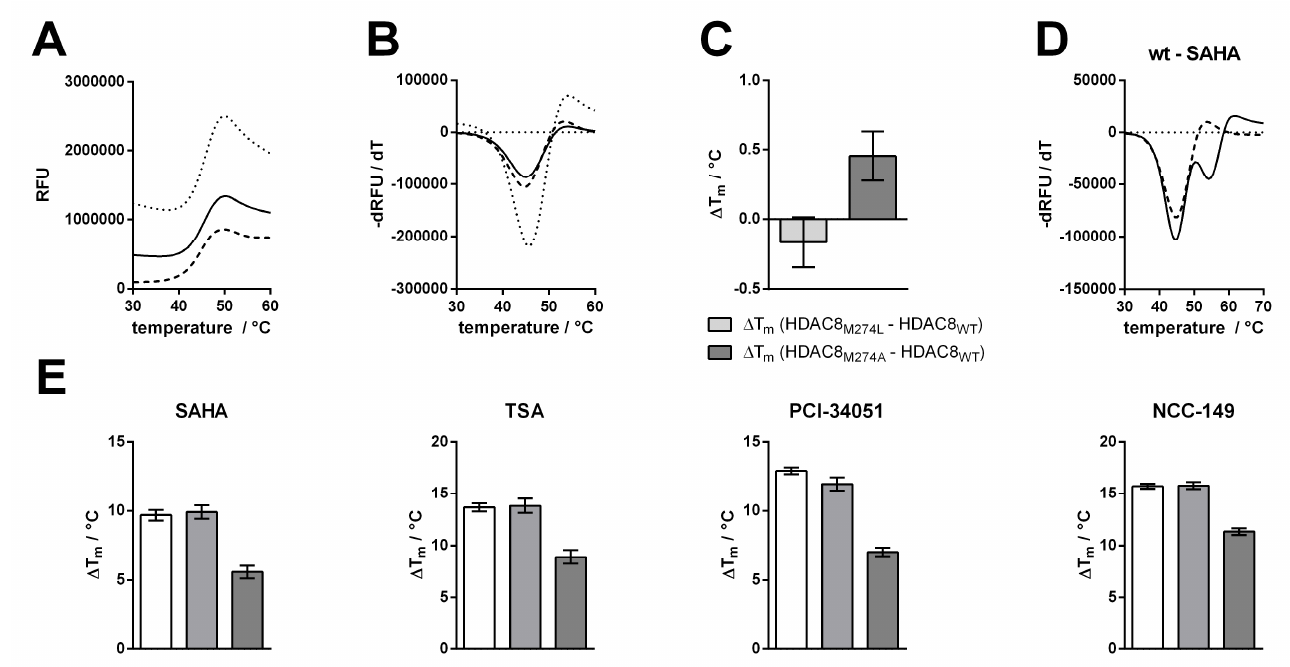
Figure 4. Determination of protein melting points and thermal shift assay. ( A ) Raw fluorescence data for the thermal denaturation of HDAC8 wt (meshed line), HDAC8 M274L (solid line), and HDAC8 M274A (dotted line). ( B ) First derivative for the thermal denaturation of HDAC8 wt (meshed line), HDAC8 M274L (solid line), and HDAC8 M274A (dotted line). ( C ) Comparison of T m values between the mutant variants and the wild type. ( D ) Thermal shift assay showing unbound HDAC8 wt (meshed line) and SAHA-bound HDAC8 wt (solid line). ( E ) Thermal shifts for SAHA, TSA, PCI-34051, and NCC-149 for HDAC8 wt (white bar), HDAC8 M274L (light gray bar), and HDAC8 M274A (dark gray bar). For the thermal shift assay, 12.5 μ M HDAC8 and 125 μ M of indicated inhibitor were used. Data show mean values and standard deviations, n ≥ 3.